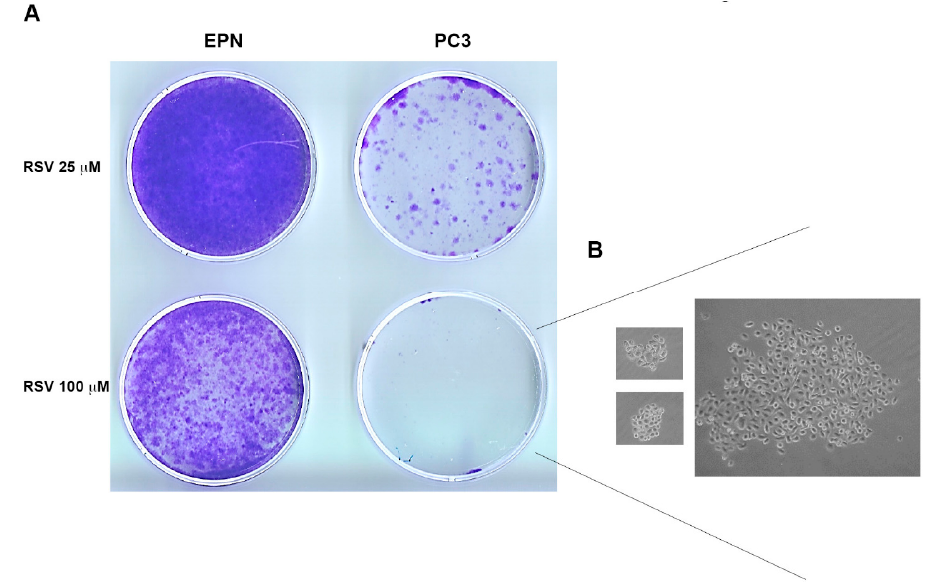
Figure 6. Colonies formed by EPN and PC3 cells post long-term RSV treatment followed by W/O: ( A ) Crystal Violet staining of cell colonies arising from EPN and PC3 cells treated with RSV (25 and 100 μ M) for seven days followed by seven days W/O; and ( B ) microphotographs of representative colonies arising from PC3 cells treated with 100 μ M RSV for seven days followed by seven days W/O. Cells have been observed with Axiovert 25 and photographed with Canon GC5 (final magnification 40×).